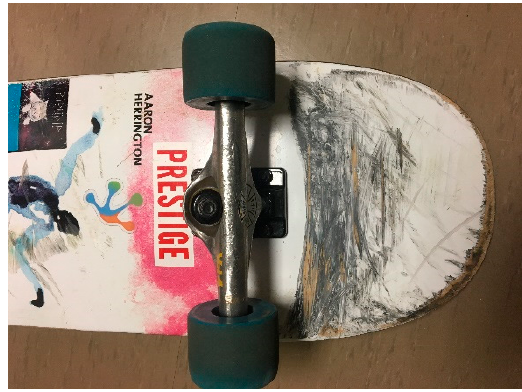
Figure 4. Skateboard Front Truck.